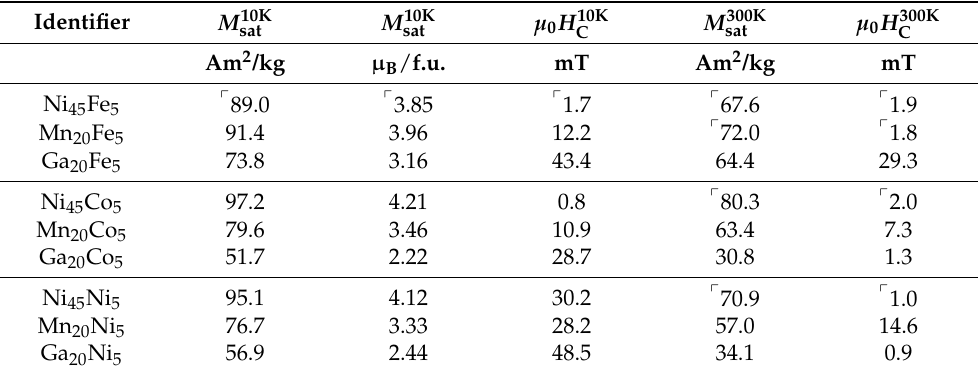
Table 4. Transition temperatures (K) determined from thermomagnetic measurement: martensite start and finish temperatures ( M s , M f ), and austenite start and finish temperatures ( A s , A f ). From these four temperatures, the single value, equilibrium martensitic transition temperature ( T m ) was calculated using formula T m = ( M s + M f + A s + A f ) /4; Curie temperature T C of martensite is marked * ; otherwise, it is austenitic T C , and an apparent Curie point is marked ** and discussed in Section 3.4.2; T pm indicates premartensitic transition temperature.